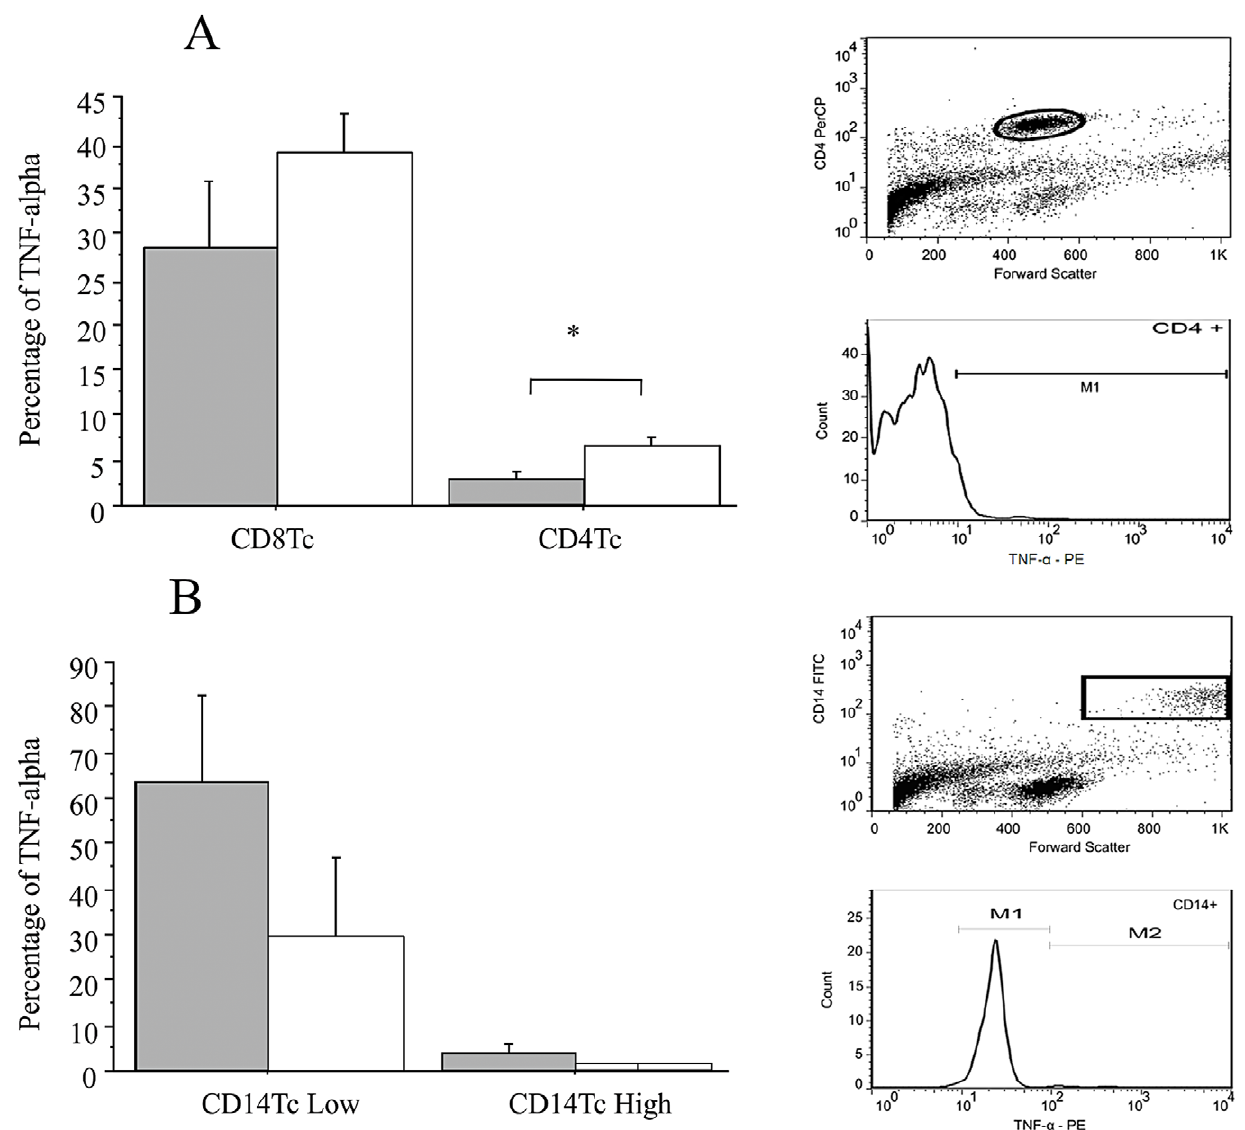
Figure 4. TNF-alpha expression on CD8 + and CD4 + lymphocytes. A. Percentage of TNF-alpha-producing cells among the CD8 + and CD4 + population of patients with the cardiac (gray bars) and indeterminate form (white bars) after 48 h of culture in the presence of T. cruzi antigens. B. Percentage of TNF-alpha-producing cells among the CD14 + population of patients with the cardiac (gray bars) and indeterminate form (white bars) after 48 h of culture in the presence of T. cruzi antigens. For analysis, a gate was established using FSC and surface marker flowed by analysis of intracellular TNF-alpha expression.